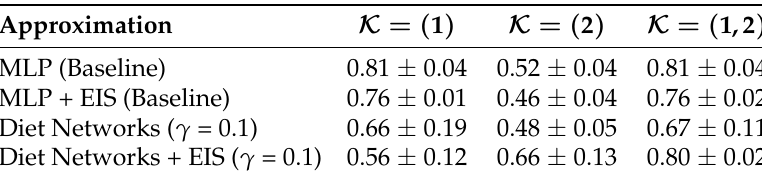
Table 4. Validation accuracy based on the various principal component analysis (PCA) approximations of each network